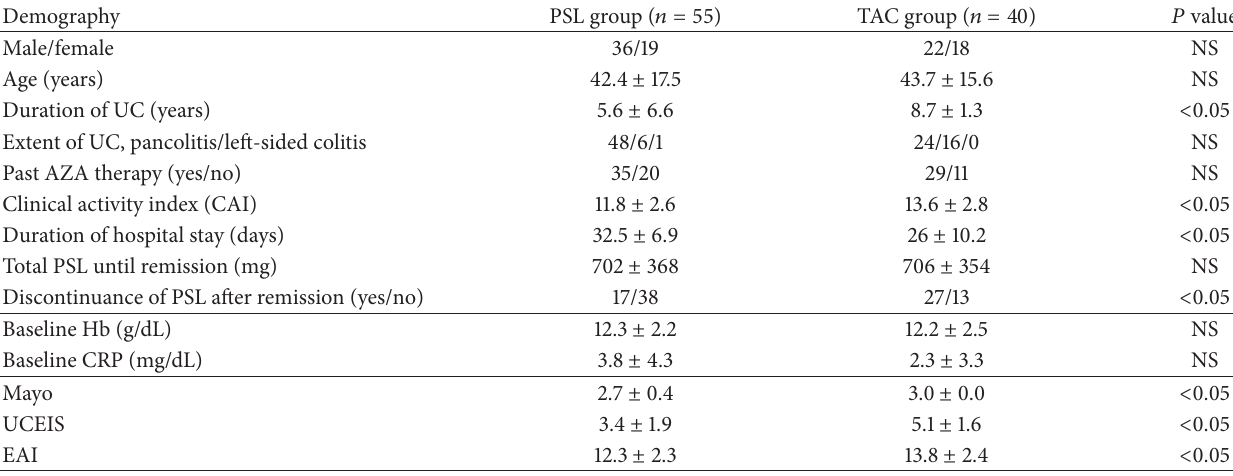
Table 1: Baseline demographics of patients with ulcerative colitis (UC) who achieved remission with prednisolone (PSL) or tacrolimus (TAC) and were retrospectively reviewed.